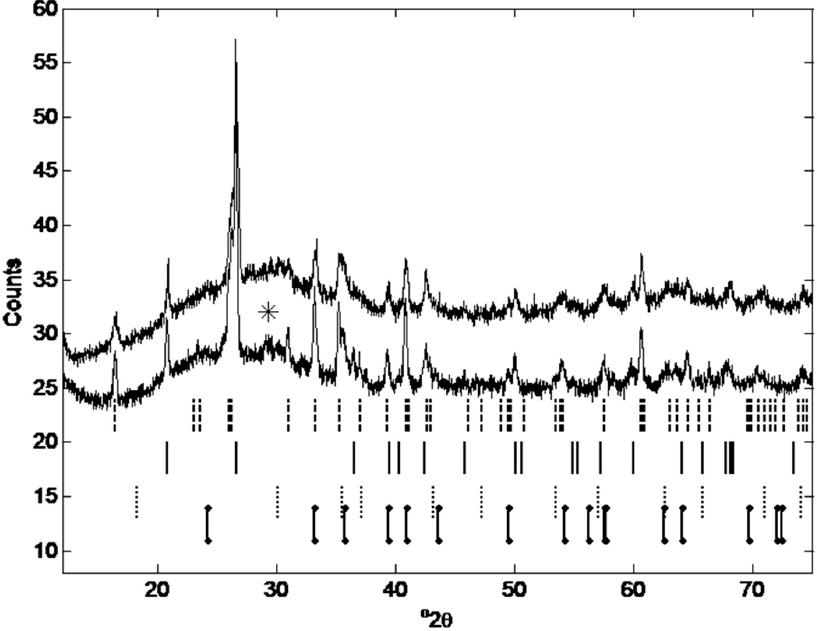
Figure 15. XRD pattern of geopolymer sample of batch 2, Table 2 (upper diffraction pattern), and of the fly ash (lower diffraction pattern). Phase identification starting from the top and moving down: dashed lines are mullite (ICSD collection code 66449), solid lines are quartz (ICSD collection code 100341), dotted lines are magnetite (ICSD collection code 82237), lowest dot-dash lines are hematite (ICSD collection code 82137). The star at 29.4 o2theta is a gypsum reflection (ICSD collection code 15982). The pattern shows an amorphous halo from approximately 20°–35° 2theta, similar to [100].